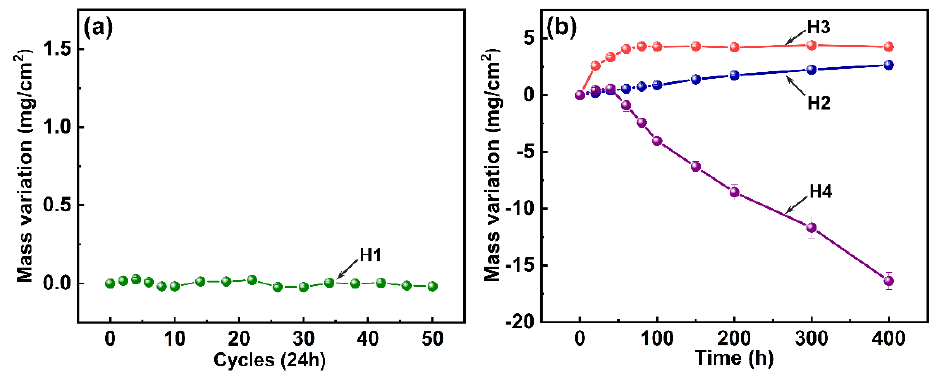
Figure 3. Corrosion kinetic curves of all tested samples: ( a ) H1; ( b ) H2, H3, H4.